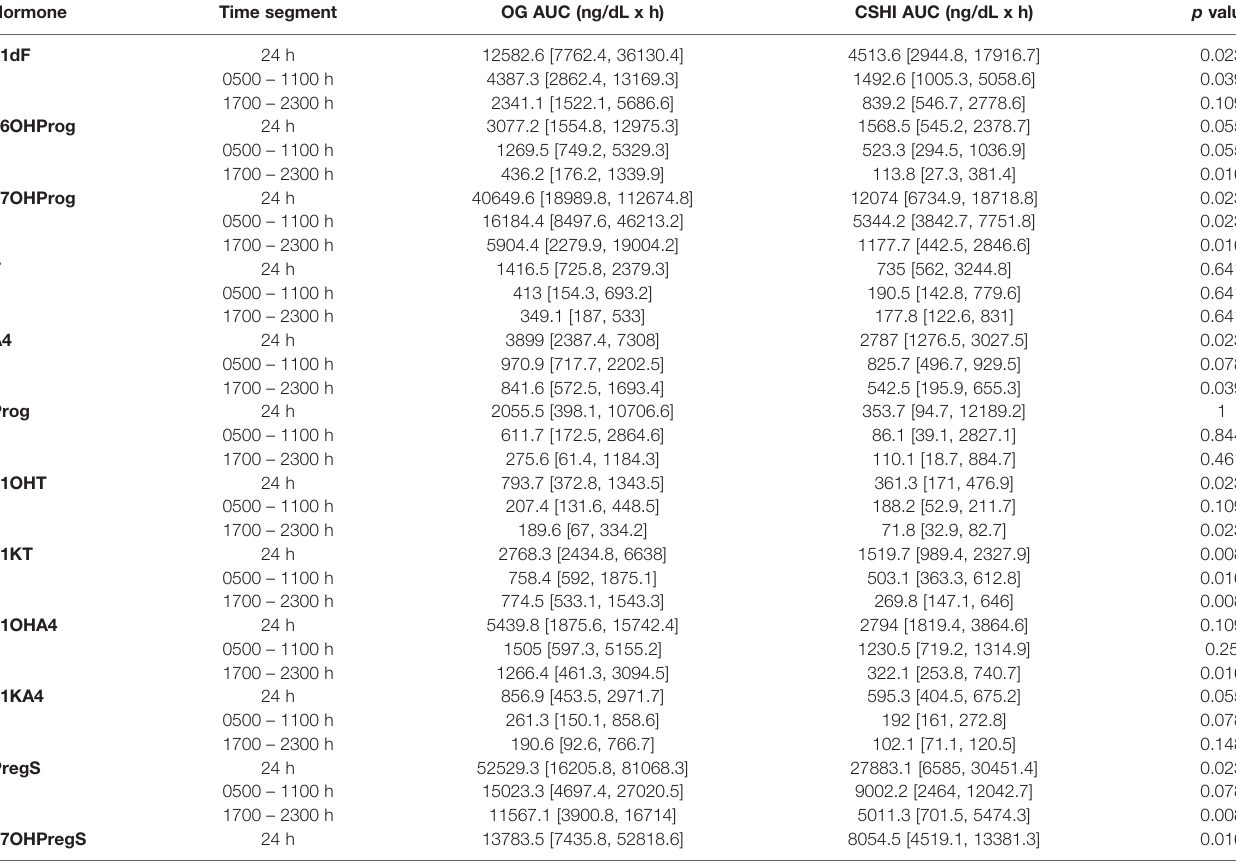
TABLE 2 | Comparison of steroid concentrations during conventional oral glucocorticoid therapy (OG) vs. continuous subcutaneous hydrocortisone infusion (CSHI).